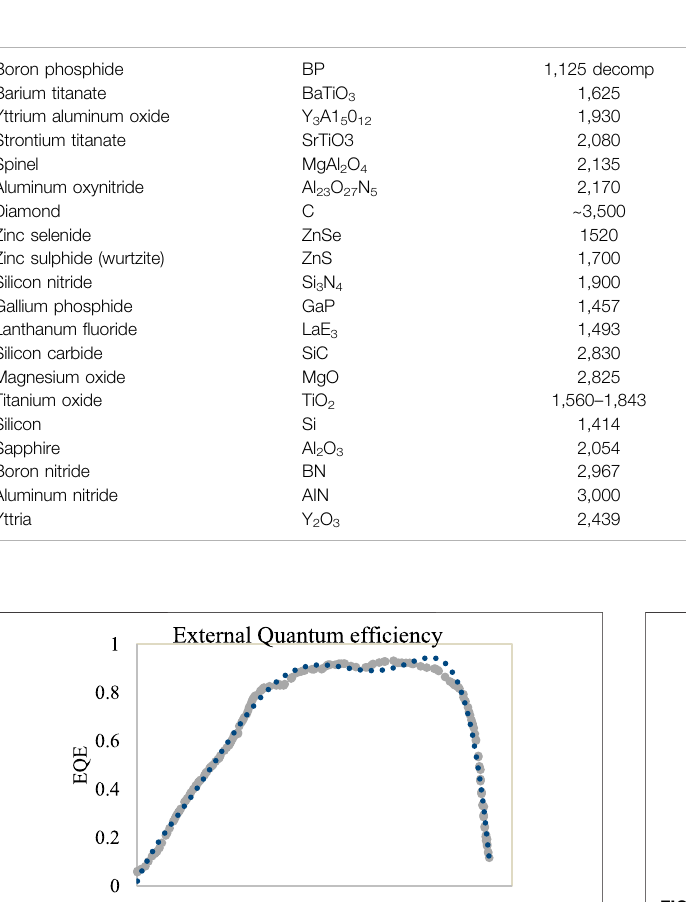
TABLE 1 | Crystalline materials used as spectral fi lters along with their melting points. Material